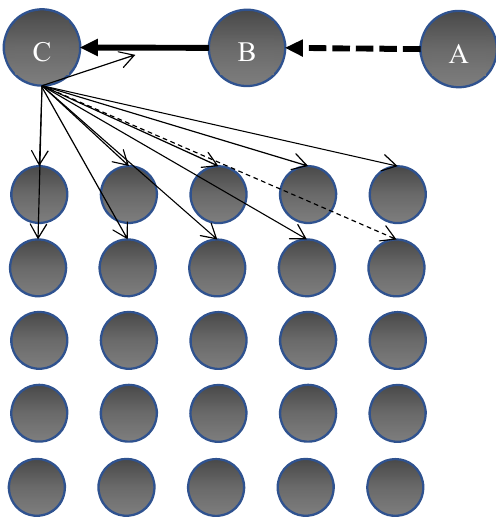
Figure 1. Simple illustration of node C receiving coin from B, and verifying with a random selection of 2 √ n nodes that the coin is not double spent; if B is relying on a previous payment from A, C verifies that transaction too with the same nodes.